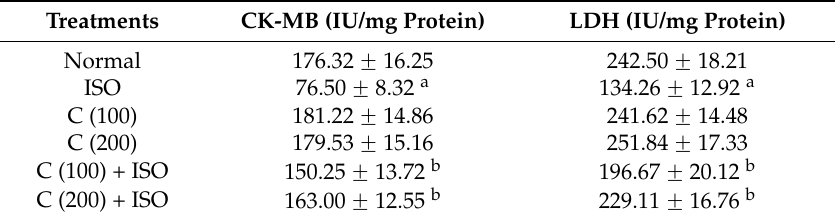
Table 2. Effect of cardamom on myocytes injury marker enzymes in isoproterenol induced myocardial infarction in